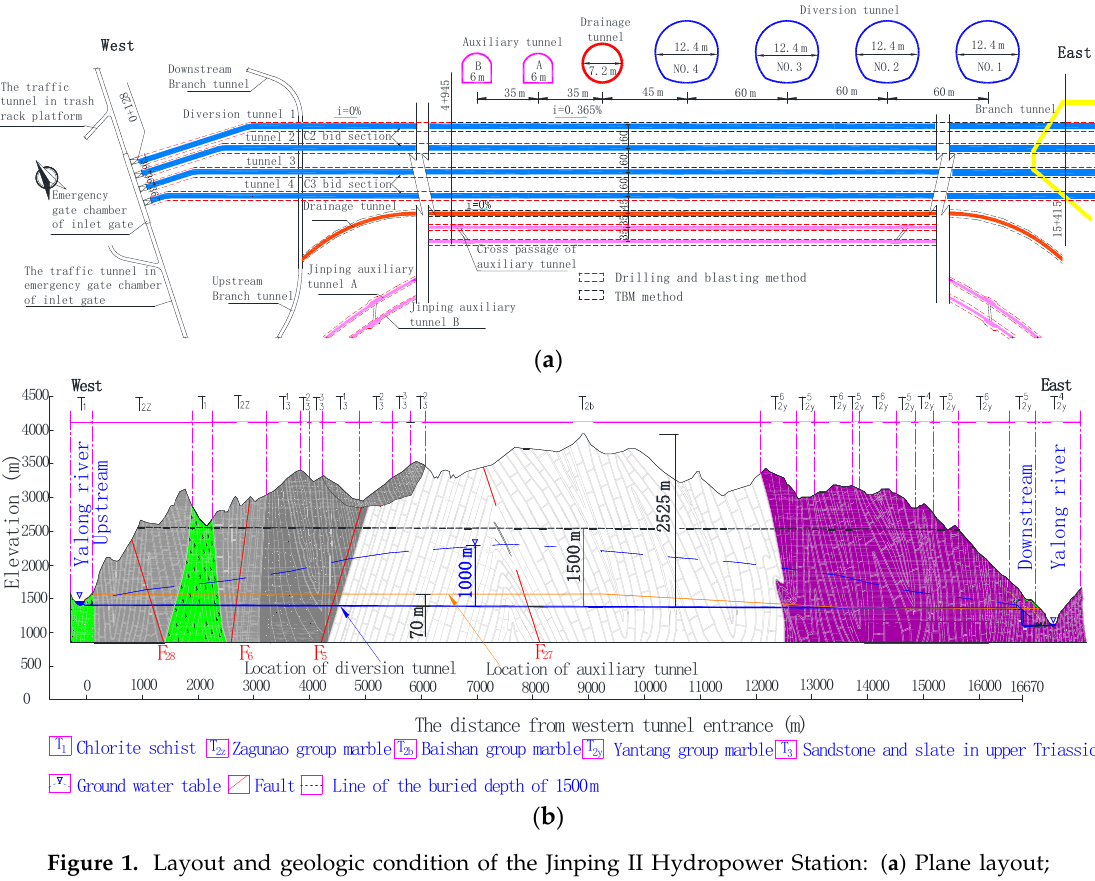
Figure 1. Layout and geologic condition of the Jinping II Hydropower Station: ( a ) Plane layout; ( b ) Engineering geologic profile